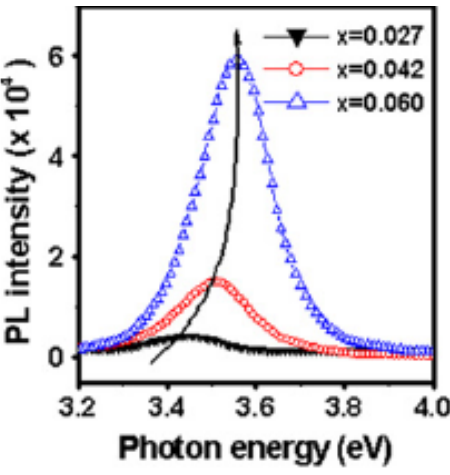
Figure 7. BEL spectra of the Zn from 3.2-3.9 eV. Reprinted from Ref. [38] with